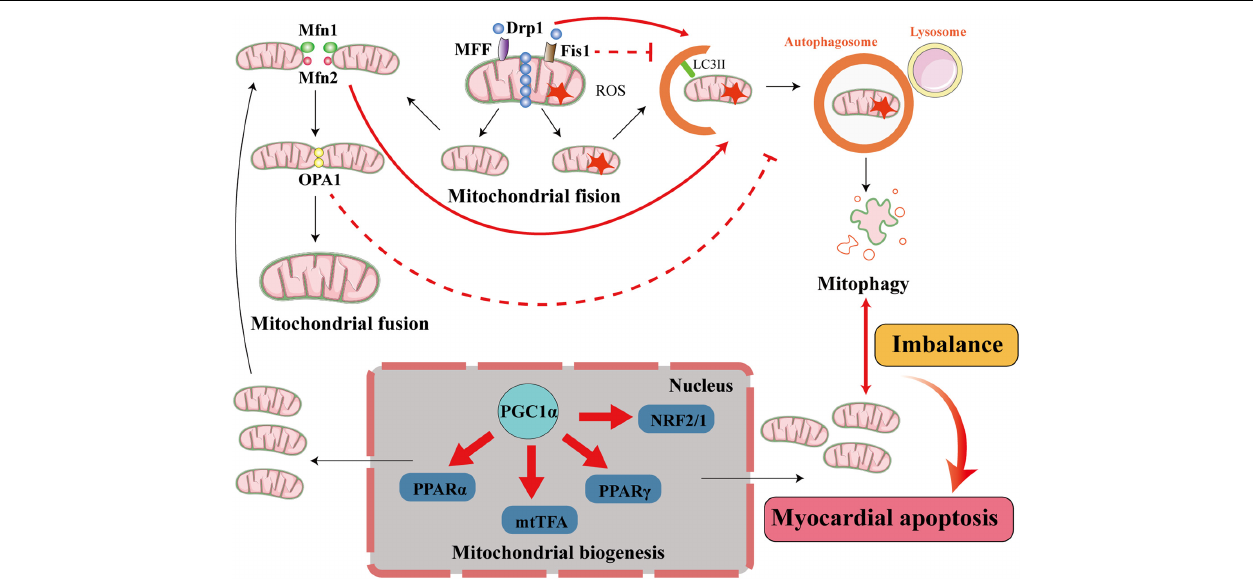
FIGURE 4 | Interactions among mitophagy, mitochondrial dynamics, and mitochondrial biogenesis in diabetic cardiomyopathy. The processes of mitochondrial quality control include mitochondrial dynamics (mitochondrial fusion and mitochondrial fission), mitophagy, and mitochondrial biogenesis. In cardiomyocytes, when mitochondria are damaged, the damaged part is removed through mitochondrial fission. This process is principally mediated by fission proteins such as Drp1, MFF, and Fis1. MFF and Fis1 recruit Drp1 to promote mitochondrial fission, and Drp1 activates mitophagy but Fis1 inhibits mitophagy. The damaged mitochondrion divides into a healthy mitochondrion and a damaged mitochondrion. The former participates in other processes, such as mitochondrial fusion, which is accomplished by the fusion proteins Mfn1/2 and OPA1. Mfn2 activates mitophagy but OPA1 inhibits mitophagy, and the damaged mitochondrion is eliminated by mitophagy. When the damaged mitochondria have been cleared by mitophagy to a certain extent, the process of mitochondrial biogenesis generates new mitochondria to supplement the mitochondrial pool. This involves transcription factors such as PPAR α , mtTFA, PPAR γ , and NRF2/1, and cofactors such as PGC1 α , and maintains the supply of energy to the myocardium. When the balance between mitophagy and mitochondrial biogenesis is lost, cardiomyocytes are